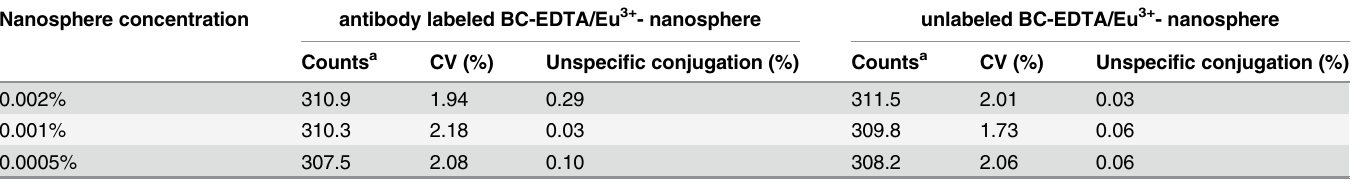
Table 1. Unspecific conjugation of antibody labeled BC-EDTA/Eu 3+ -nanosphere, unlabeled BC-EDTA/Eu 3+ -nanosphere to antibody coated micro- well plate. Nanosphere concentration